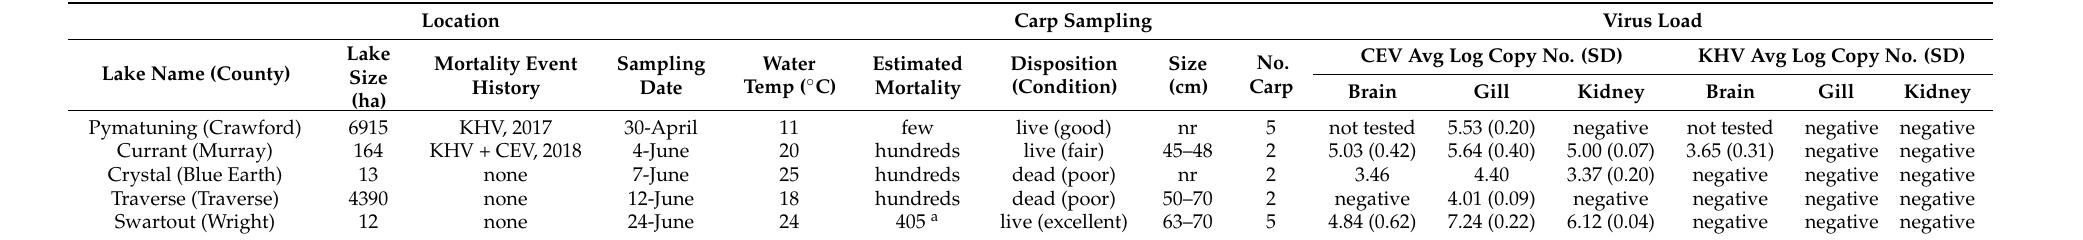
Table 2. Study lakes and screening of wild